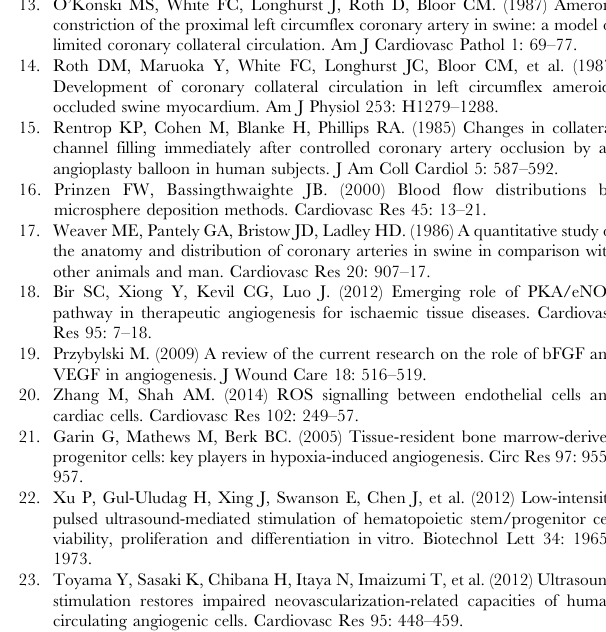
Figure S2 In vitro study. ( A ) LIPUS therapy did not up- regulated mRNA expression of eNOS or bFGF at 32-cycle. Results are expressed as mean 6 SEM (n= 8 each). ( B ) LIPUS therapy significantly increased the ratio of phospho-eNOS to total-